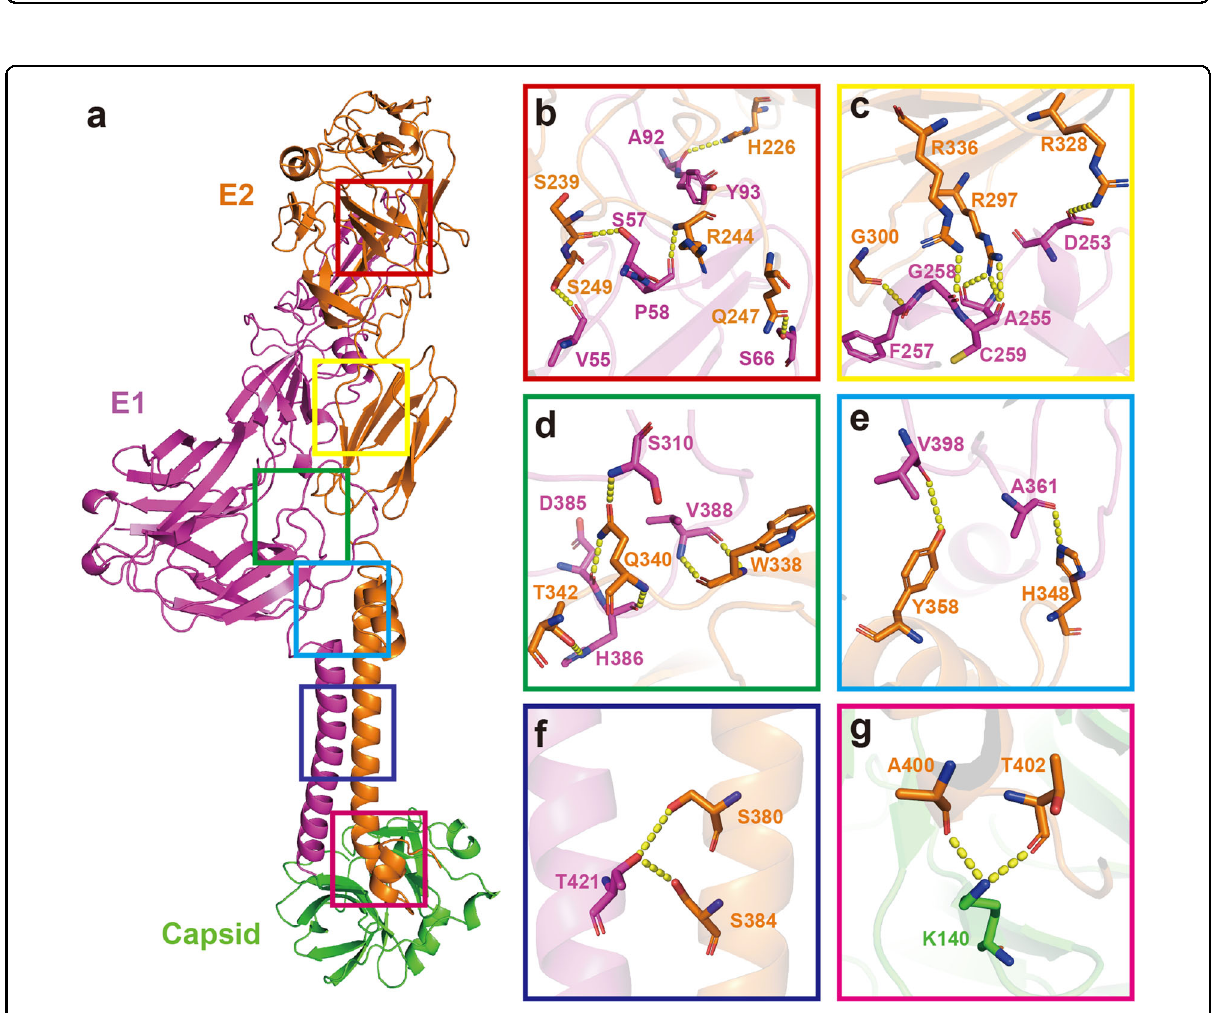
Fig. 2 Interaction of GETV protein subdomains in the E1 – E2 – Capsid heterotrimer. a Distribution of interaction regions between E1 and E2 and between E2 and the capsid protein. b – f Zoomed-in views from a of the interaction regions between E1 and E2. g Zoomed-in view from a of the interaction region between E2 and the capsid protein. The yellow dashed lines indicate the distance between the atoms involved in the interaction (the cut-off distance is 3.5